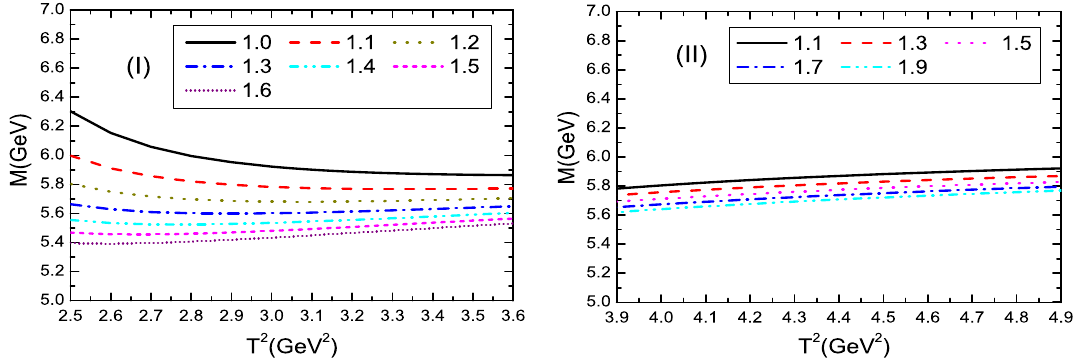
Fig. 4 The masses of the triply-charmed pentaquark states with variations of the Borel parameters T 2 and energy scales μ , where the (I) and (II) denote the negative parity and positive parity pentaquark states, respectively, the 1 . 0, 1 . 1, 1 . 2, ··· denote the energy scales μ of the QCD